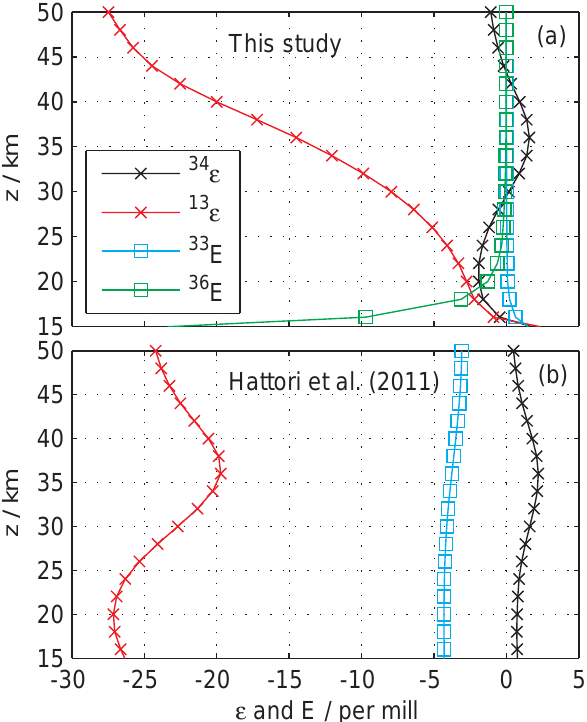
Fig. 5. (a) The photolytic fractionation constants 34 (cid:15) and 13 (cid:15) , and the quantities 33 E and 36 E as defined in Eqs. 4 and 5 as a func- tion of altitude calculated using the theoretical temperature depen- dent cross sections. The actinic flux as an a function of z was taken from McLinden et al. (2002) while the temperature was modeled using the US standard atmosphere. (b) Same as (a) but using the experimental cross sections of Hattori et al. (2011) (fixed at room